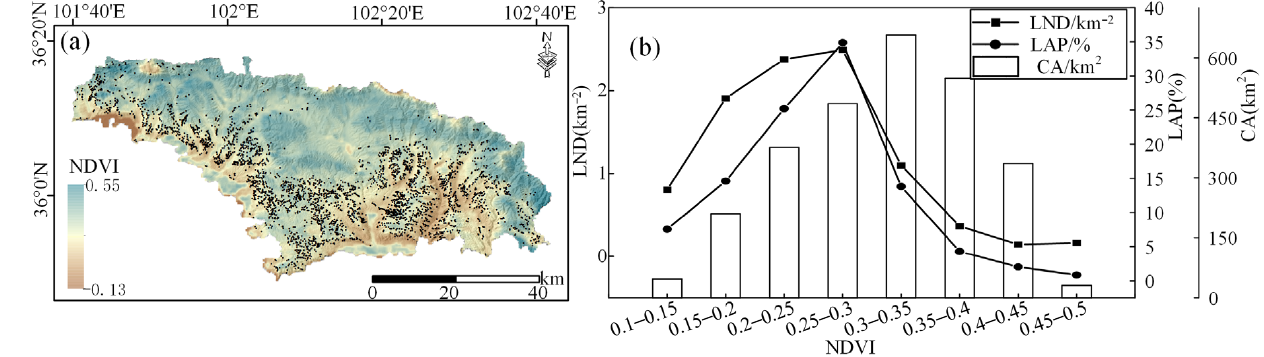
Figure 16. Relationship between NDVI and landslide distribution. ( a ) NDVI distribution in the study area. ( b ) Statistics of landslide indicators in the NDVI intervals.